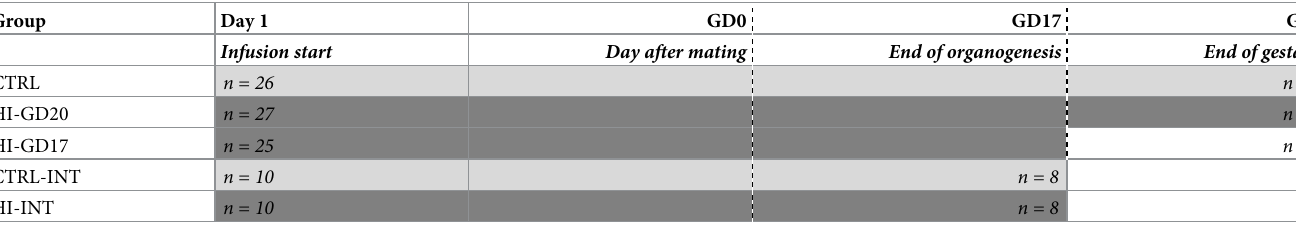
Table 1. Study design.